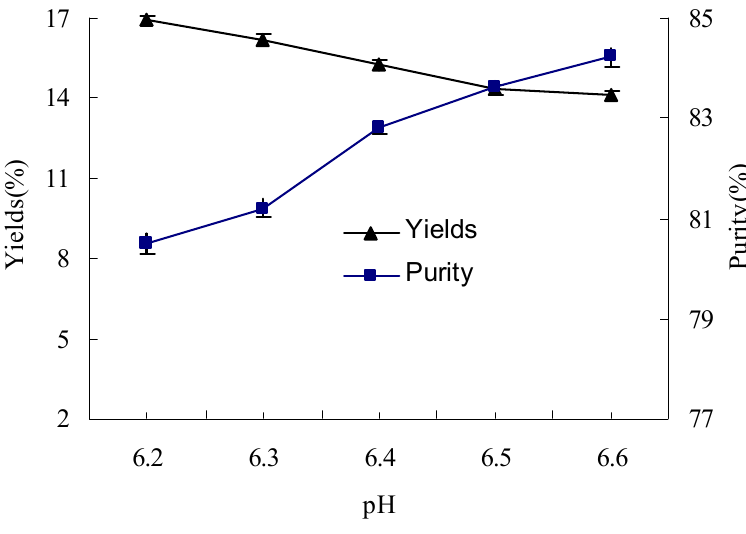
Figure 1. The effect of pH on yields and purity of glycinin